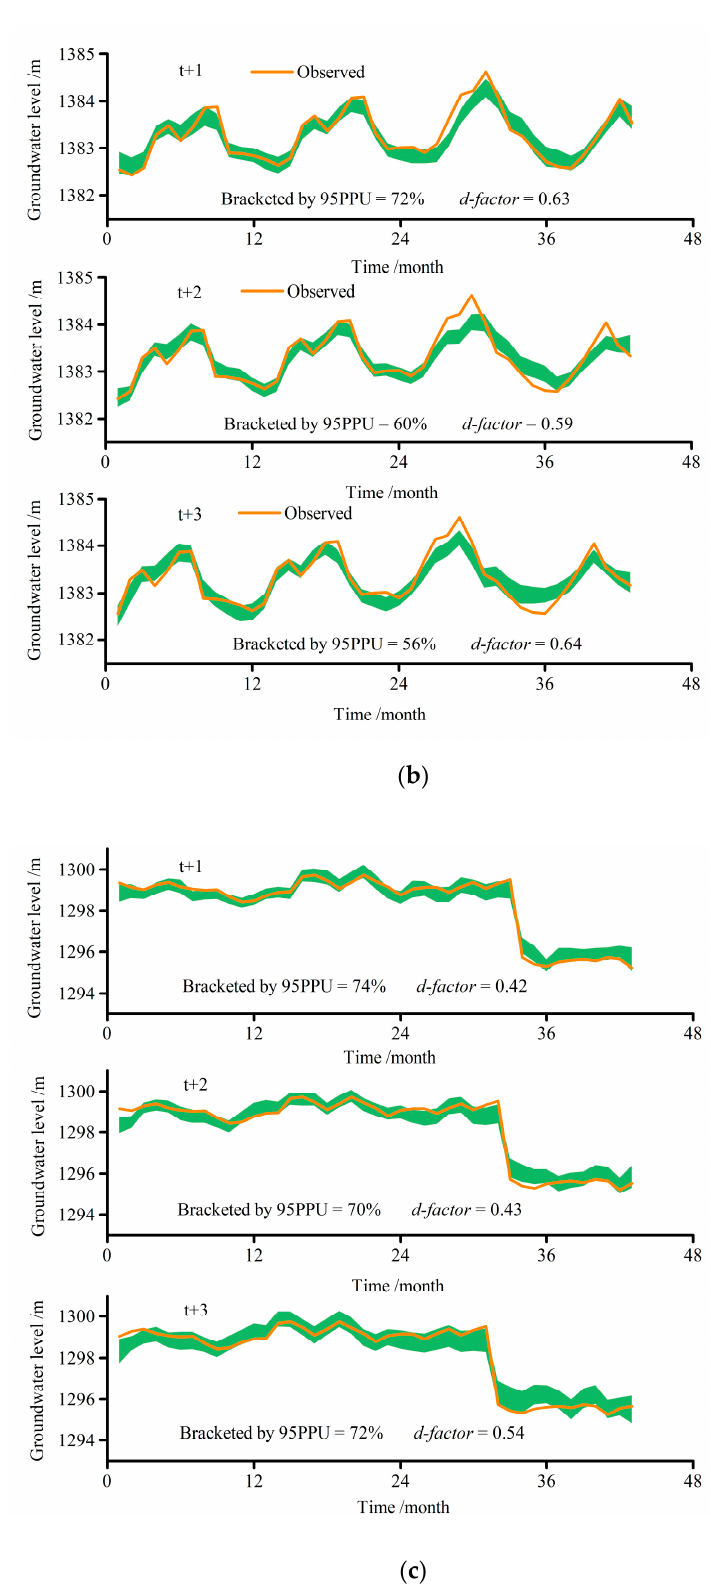
Figure 10. Observed groundwater level and the 95% confidence intervals forecasted by VELM model with randomly sampled input vectors for 1, 2 and 3-months ahead forest during the testing period at Well I ( a ), Well II ( b ) and Well III ( c ).